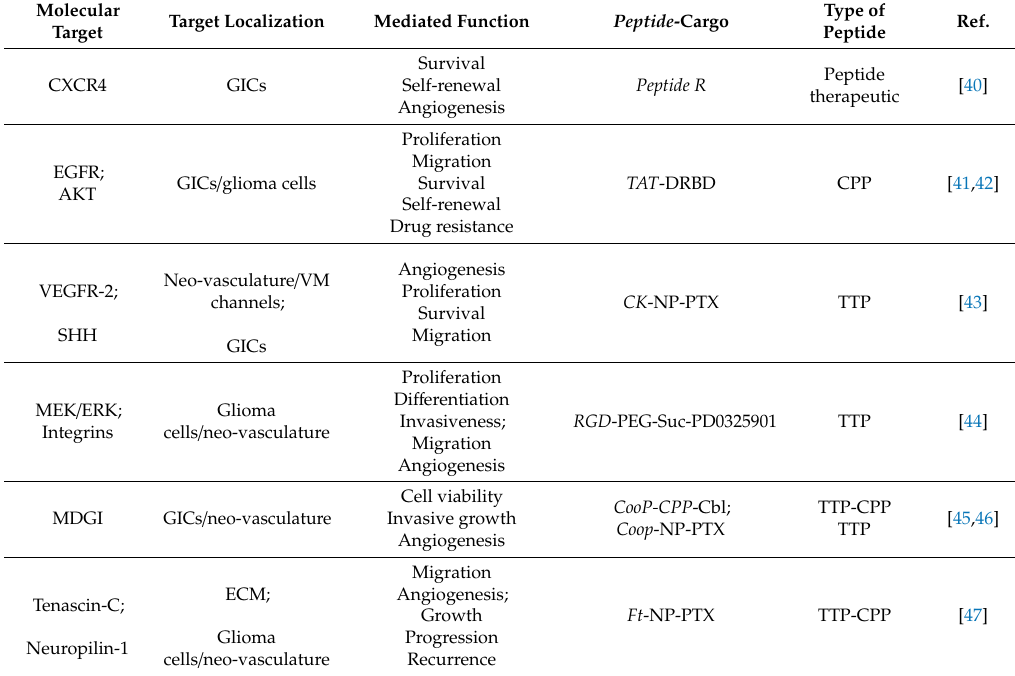
Table1. Mainanti-cancerpeptidesactingonmoleculartargetsthathavebeentestedinpreclinicalstudies. Molecular